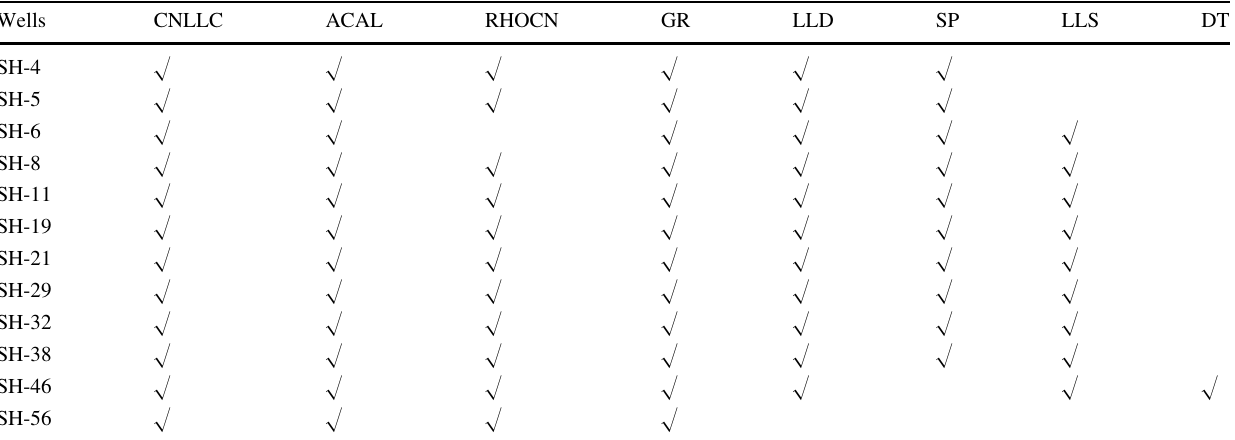
Table 1 Well log data available for this study